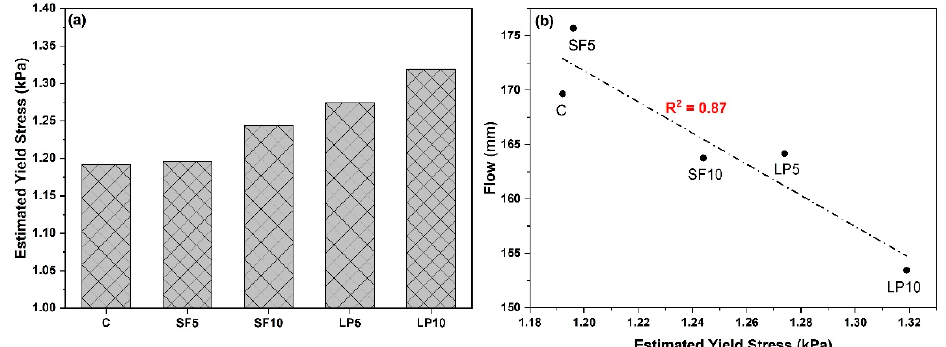
Figure 7. ( a ) Yield stress ( b ) correlation between estimated static yield stress and flow of printable mixtures.